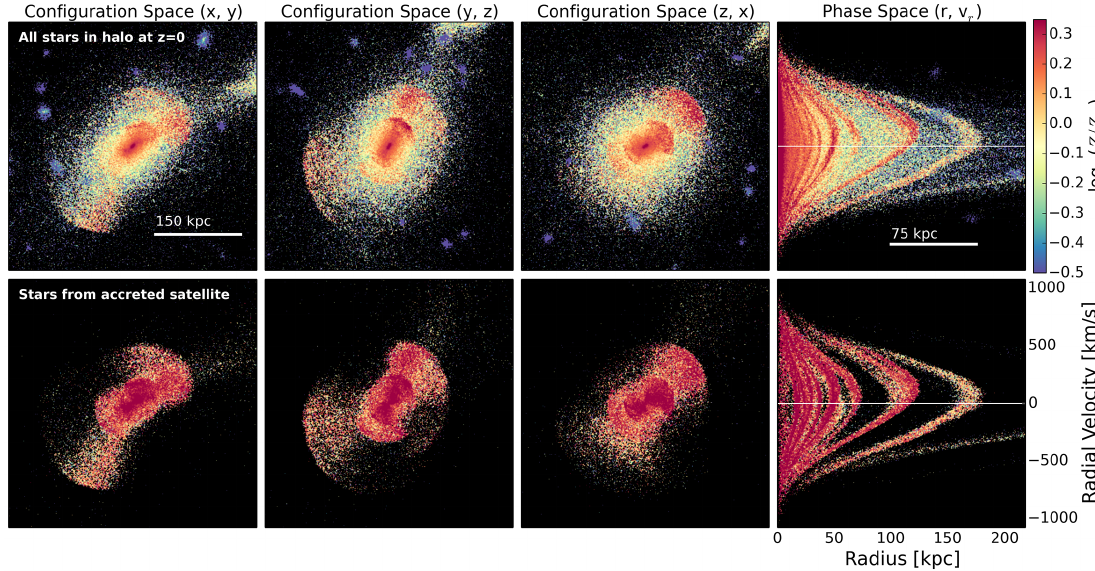
Figure 1. Stellar maps in configuration space (first three columns) and phase space, i.e., radial velocity vs. radial distance (last column). The color of each bin of area A bin = ( 1.5kpc ) 2 in the 2D histograms above corresponds to the median total metallicity (Z) of all star particles therein. Top row : entire halo of a redshift z = 0 shell galaxy with total stellar mass M stars = 6.3 × 10 11 M (cid:12) , virial mass M 200crit = 1.4 × 10 13 M (cid:12) , and effective radius R eff = 16.3kpc (where R eff is defined as the radius that contains half of the total light in a galaxy). Bottom row : redshift z = 0 stars that have been accreted from the same common progenitor, which is responsible for the shell structures in the top row. We find that stellar shells in this galaxy have higher total metallicities than stars in the outer regions of the stellar halo. Moreover, we find a gradient in the average metallicity of individual shells, with outer shells having lower average Z that inner